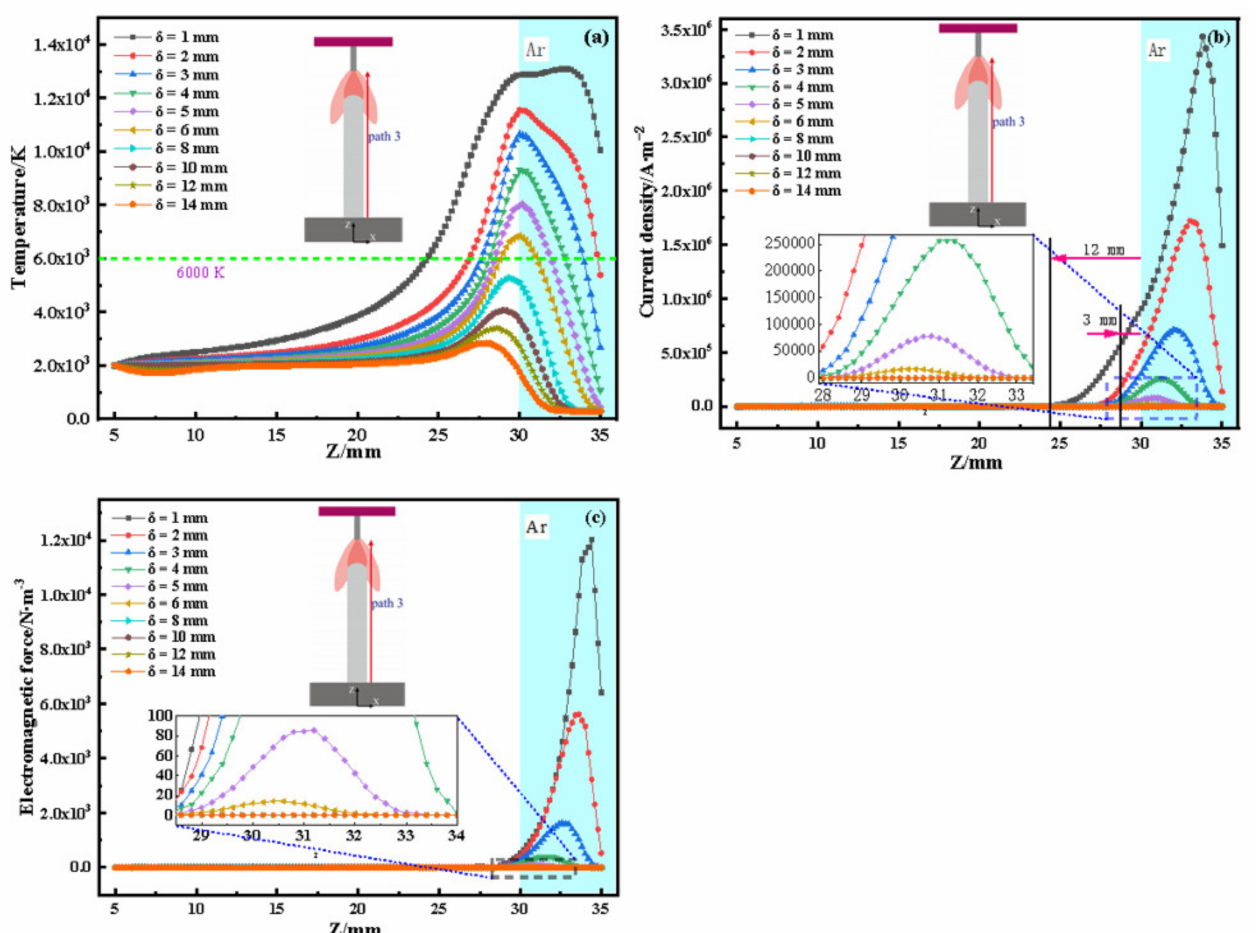
Figure 7. Distribution of main parameters on path 3: ( a ) temperature; ( b ) current density; ( c ) electromagnetic